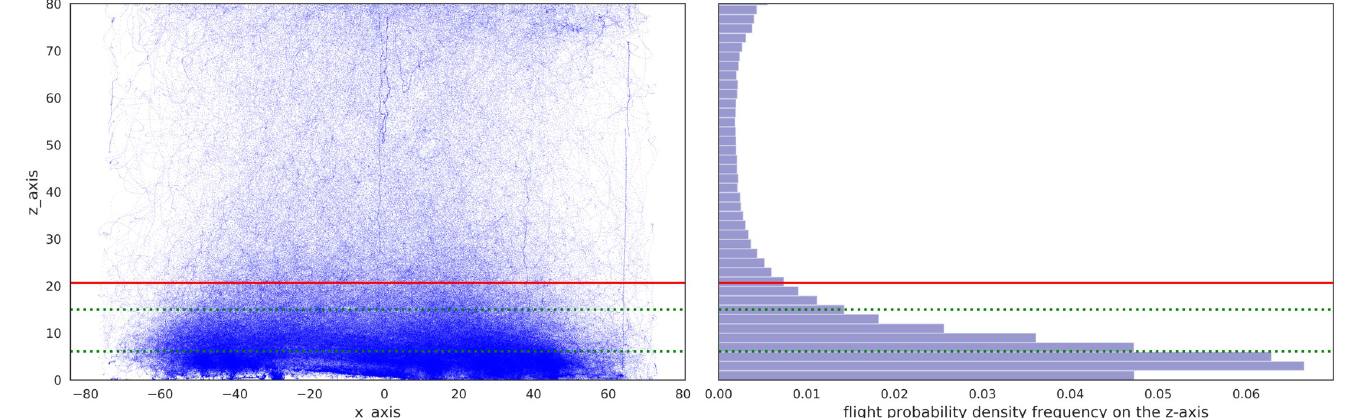
Fig 2. Overall spatial distribution of all flights of bumblebees in the arena under cue-conflict conditions. A: representation of all the flights obtained under cue conflict conditions (n = 107 flights) along the x-axis and z-axis inside the arena. The bee’s position at each point in time is represented as a blue dot. Below the red line 75% of the flight time takes place. The two green dotted lines are the two altitudes for which a set of images has been taken from the perspective of a bee (6cm and 15cm). While searching for the nest hole in cue conflict situations bumblebees fly relatively close to the ground. Nevertheless, numerous data points are visible at higher altitudes; this is due to bumblebees abandoning their search or colliding with the perspex lid at 90 cm above the ground. B: Histogram representing the frequency distribution of flights along the z-axis of the arena.